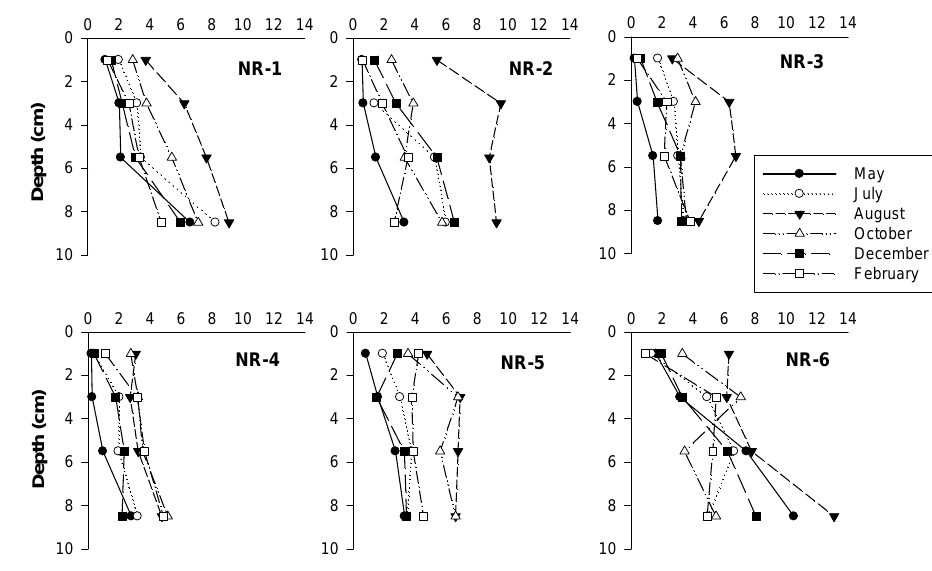
Fig. 6. Porewater concentrations for PO 3 −